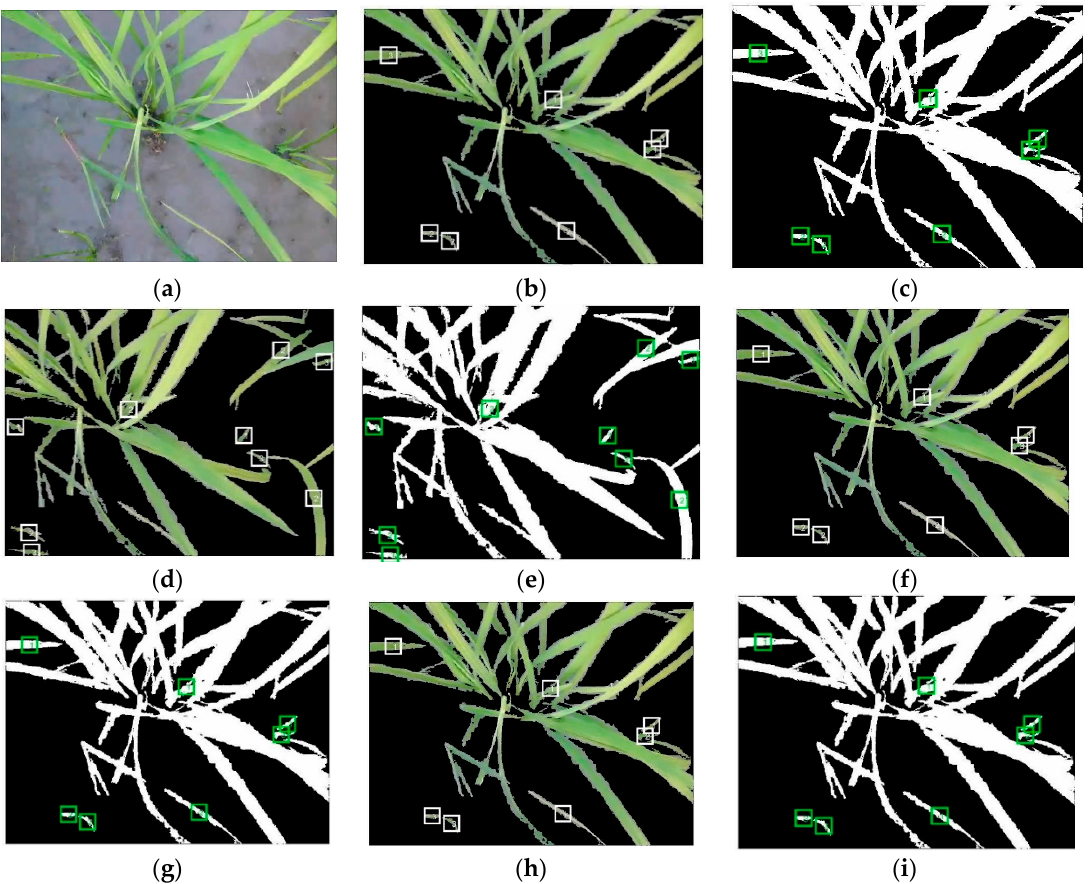
Figure 5. Segmentation and classification of rice and weeds in color and binary images for a frame. ( a ) Original frame, ( b ) color model of left channel, ( c ) binary model of left channel, ( d ) color model of right channel, ( e ) binary model of right channel, ( f ) color model of arithmetic mean, ( g ) binary model of arithmetic mean, ( h ) color model of geometric mean, and ( i ) binary model of geometric mean.